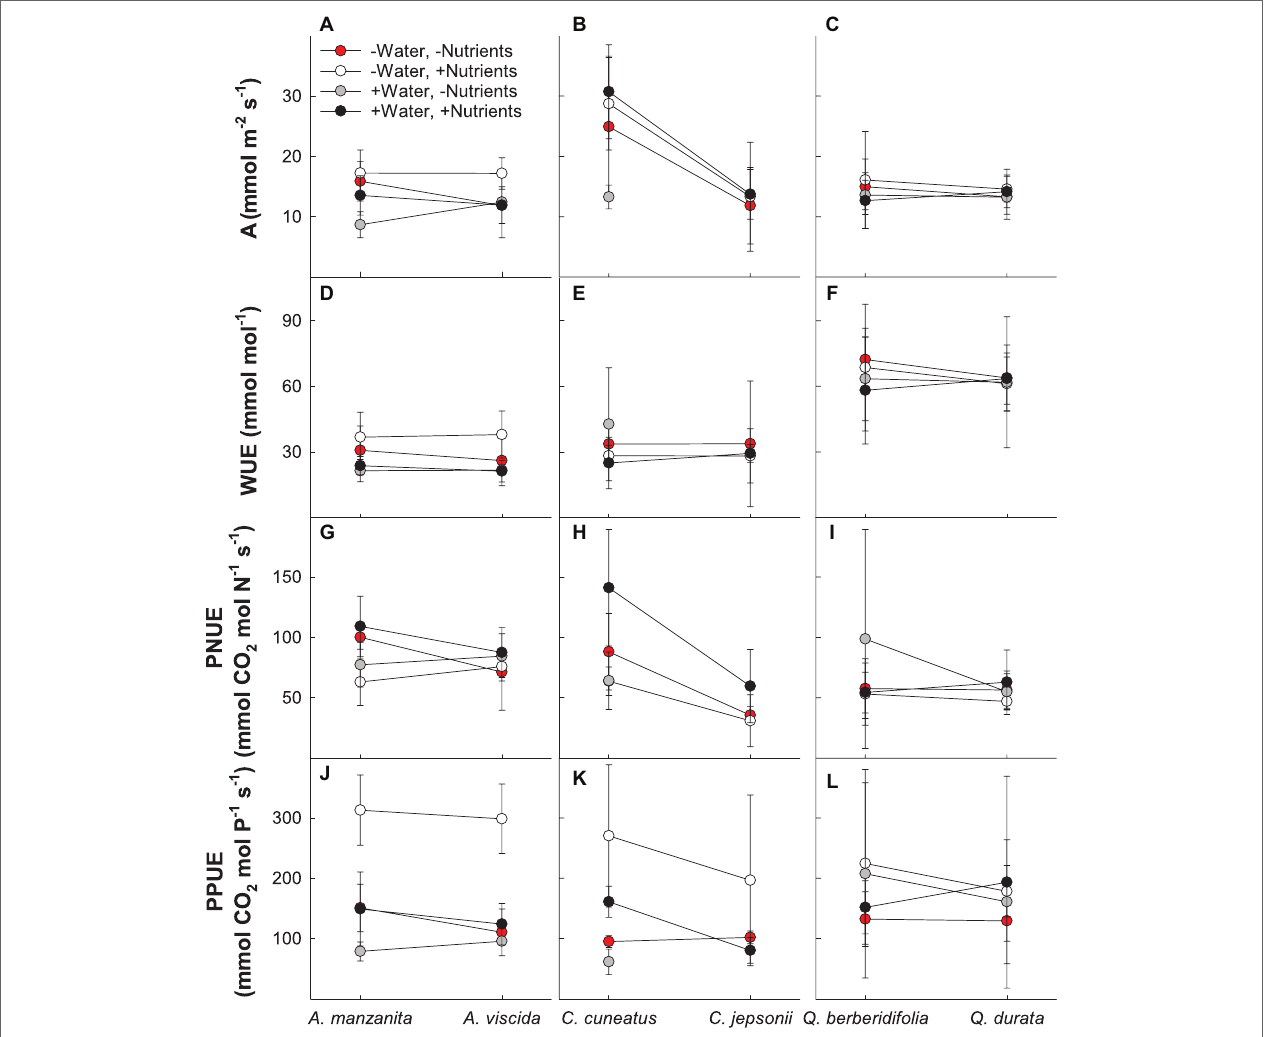
FIGURE 1 | Gas exchange responses of plants exposed to contrasting water and nutrient treatments, including photosynthetic rate (A; A–C ), intrinsic water use efficiency (WUE; D–F ), photosynthetic N use efficiency (PNUE; G–I ), and photosynthetic P use efficiency (PPUE; J–L ). First plant in each congener pair originates from non-serpentine soil; second plant in each congener pair originates from serpentine soil. Data are means ± S.D. ( n =